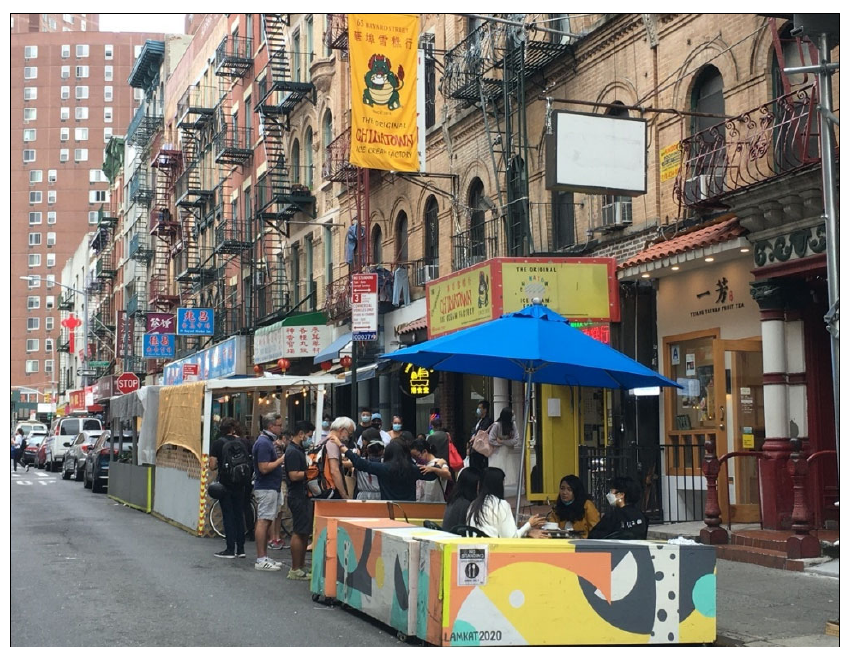
Figure 2. People enjoy outdoor dining on a warm Saturday in late September 2020 thanks to Assembly for Chinatown. Photo by